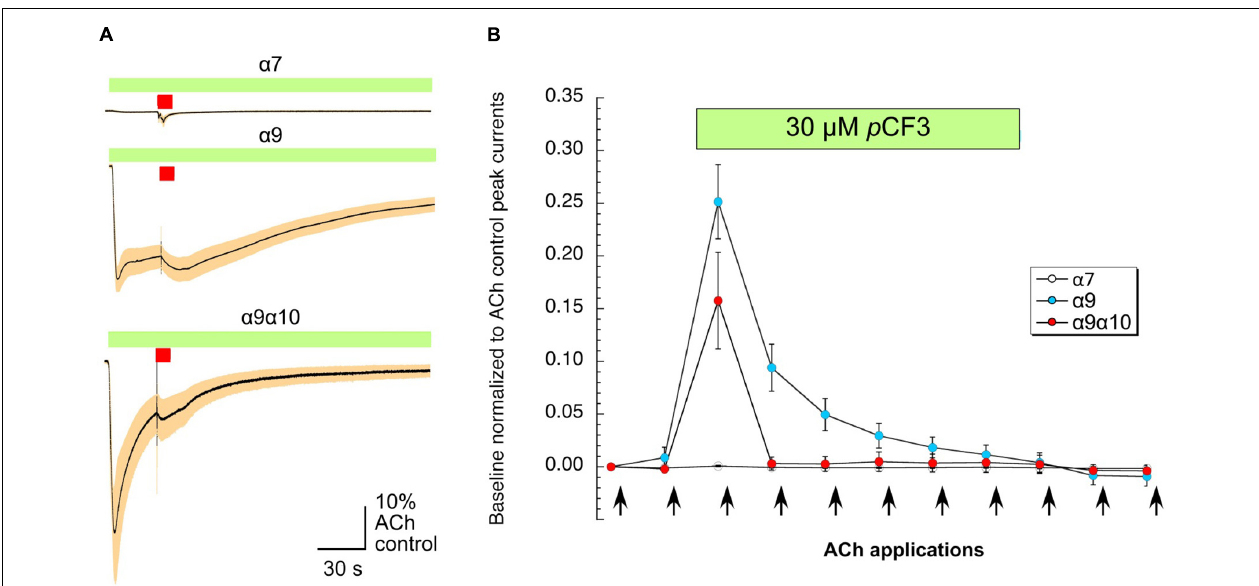
FIGURE 6 | Baseline currents during the applications of 30 µ M p CF3-diEPP ( p CF3). Two-electrode voltage-clamp measurements were performed on Xenopus laevis oocytes heterologously expressing human α 7, α 9 or α 9 α 10 nAChRs. (A) Averaged responses of oocytes heterologously expressing human α 7 nAChRs (upper trace, n = 6), α 9 nAChRs (middle trace, n = 7), or α 9 α 10 nAChRs (lower trace, n = 7) to the onset of the bath application of 30 µ M p CF3 and the co-application with acetylcholine (ACh, 60 µ M, red bar). The data from each cell were first normalized to the peak current amplitude of the ACh control response that preceded the bath application of 30 µ M p CF3. The normalized data were then averaged (black lines) at each of the 10,000 points in the data traces and SEMs calculated and displayed as the tan-colored bands. The scale bar represents 10% of the averaged ACh controls, which were 5.1 ± 1.3 µ A, 128 ± 33 9 nA, and 2.95 ± 0.97 µ A for α 7, α 9, and α 9 α 10 nAChR-expressing cells, respectively. (B) The shift in baseline was measured over the initial 30 s intervals of subsequent acquisition periods as the absolute value of the average current during that time minus the holding currents prior to the first two ACh (12 s pulses, indicated by arrows) controls. These values were then normalized to the peak currents of the ACh controls in the same